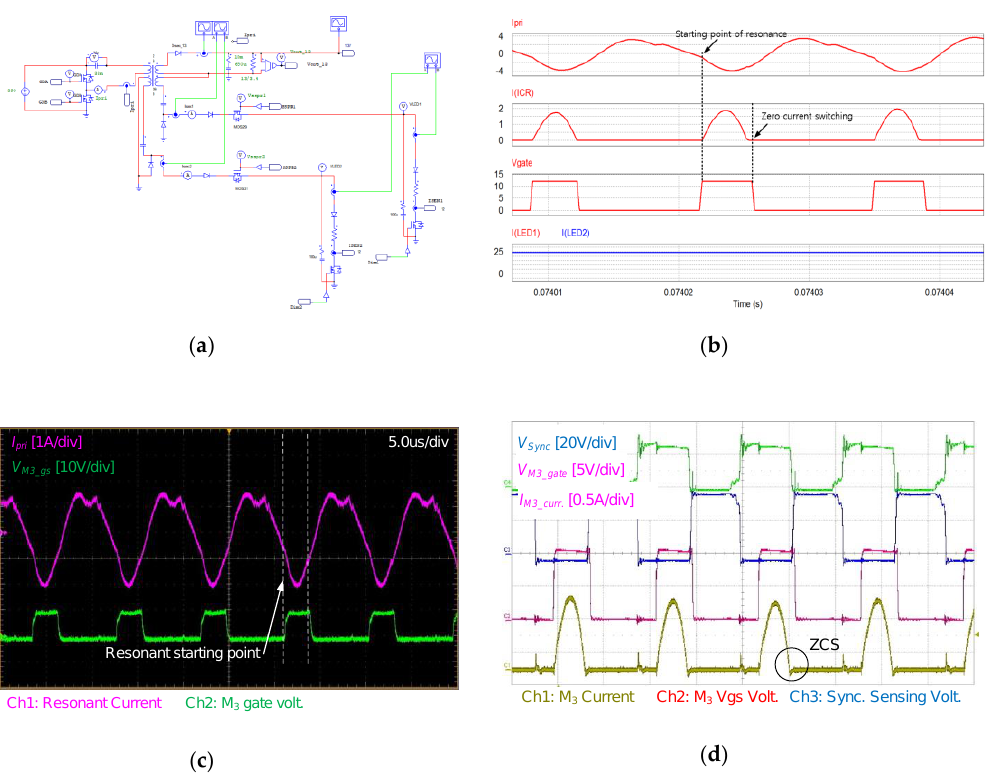
Figure 10. Computer simulation and experimental waveform of M 3 : ( a ) PSIM simulation circuit;